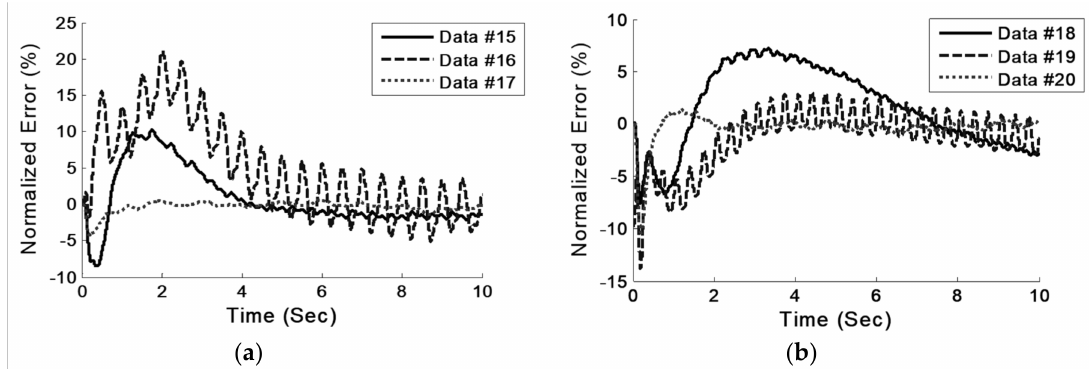
Figure 23. Normalized error of Model 2 in di ff erent tests. ( a ) Tested with Data #9 to Data #11 ( b ) Tested with Data #12 to Data #14.